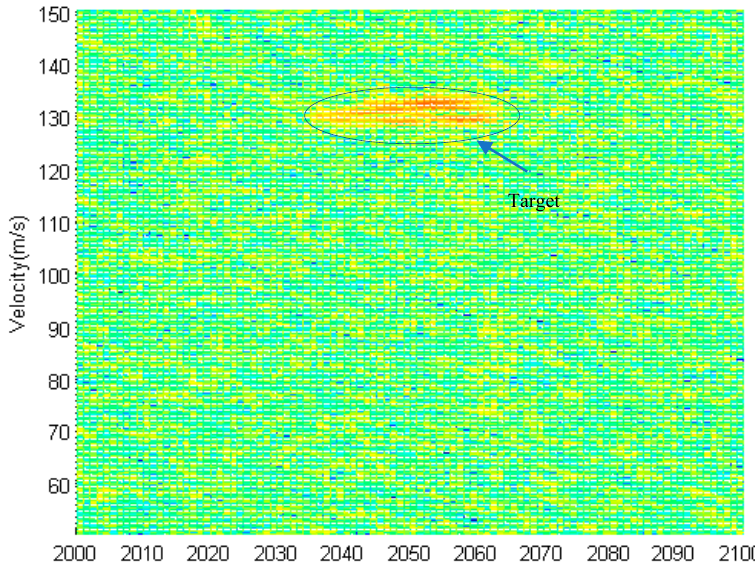
Figure 6. Coherent result of conventional FFT.